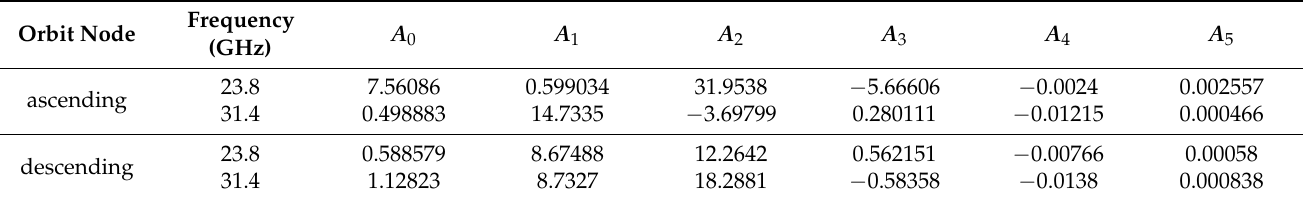
Table 3. Coefficients used to correct NOAA-20 ATMS cross-track asymmetry.